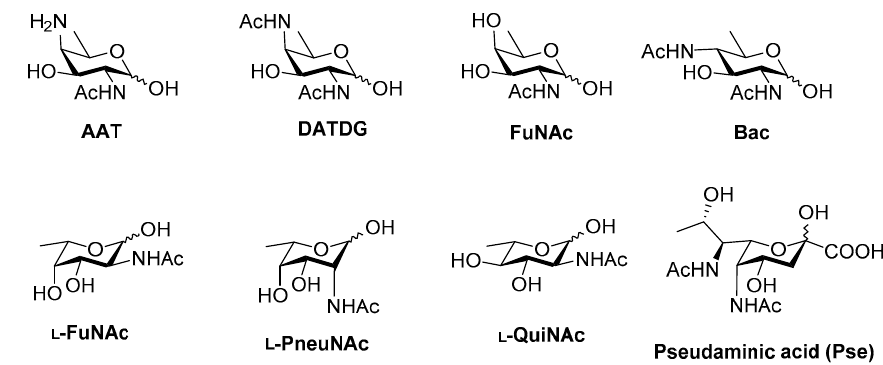
Figure 1. Representative examples of rare deoxy amino monosaccharides present in bacteria.